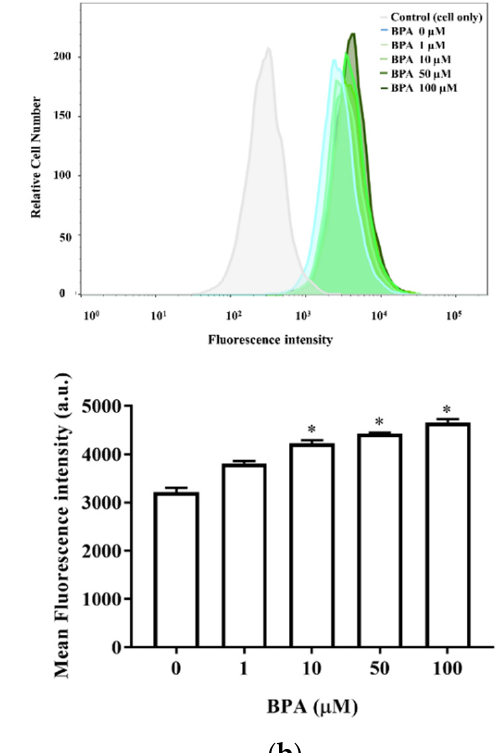
ROS levels were determined according to fluorescence intensity. The boxplots present the median (central horizontal line), 25th and 75th quartiles (upper and lower limits of the box), and the max- imum and minimum range values (error bars). The results are expressed as the mean ± SD of six independent experiments. * p < 0.05 vs. control (without BPA) group.